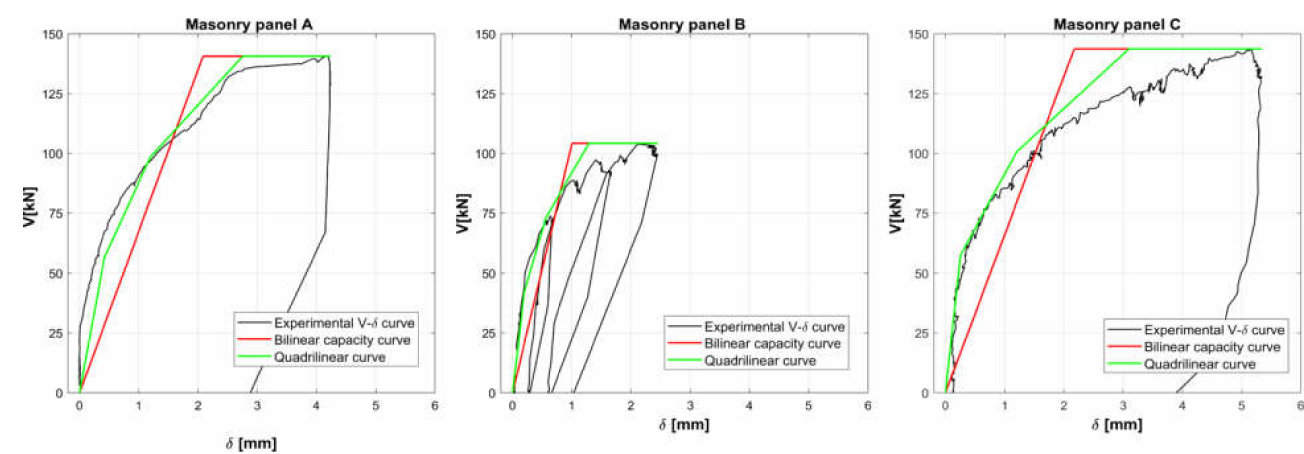
Figure 14. Experimental shear capacity curves of tested stone masonry walls (in black), bilinear approximation (in red), and quadrilinear curve (in